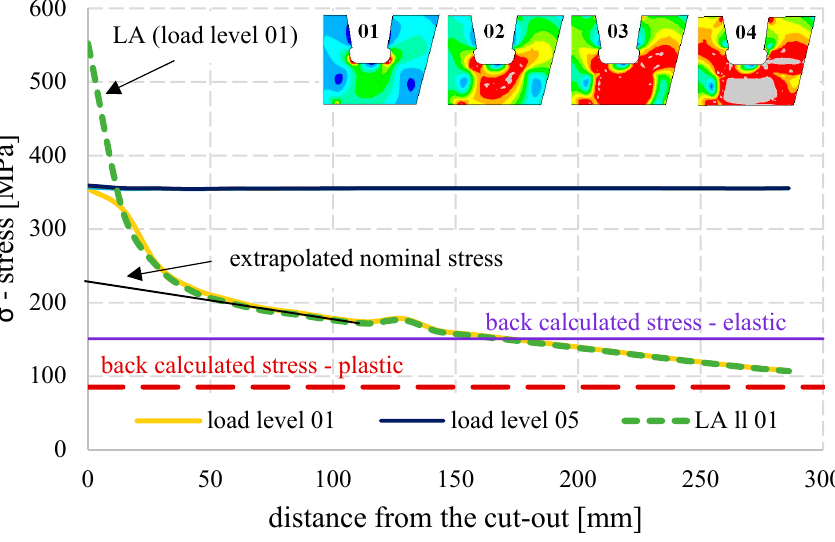
Figure 14. von Mises stresses obtained along the evaluation path (mesh size 15 mm).